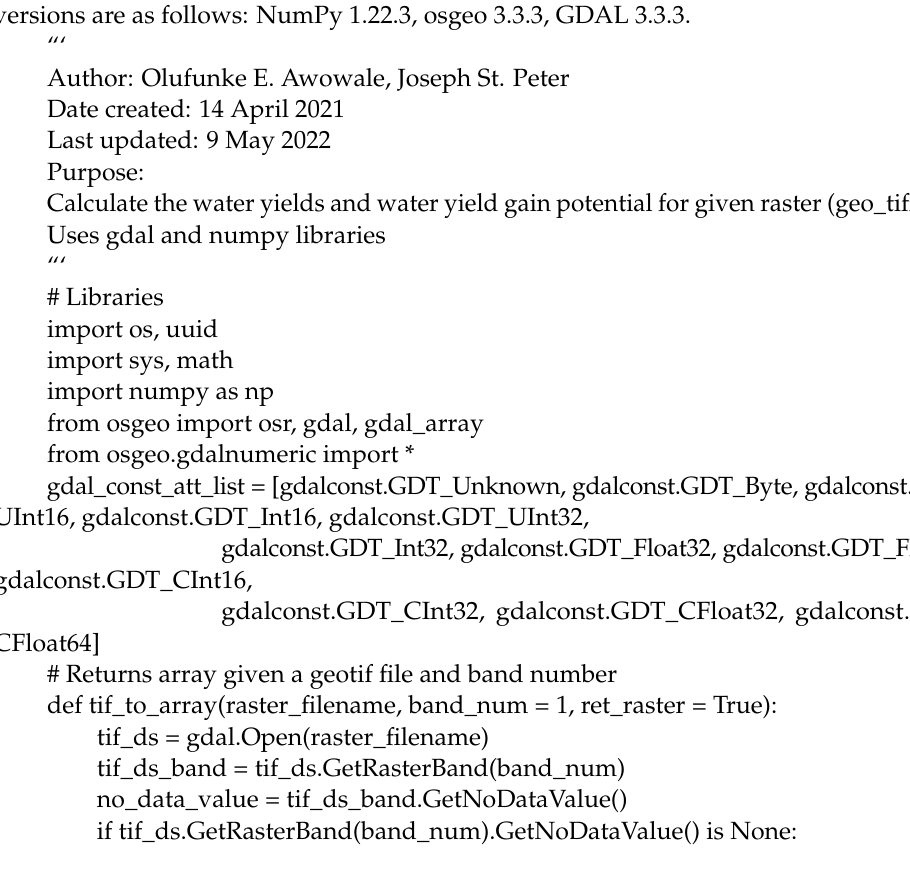
Figure A6. The geoprocessing window when using the Scenario Water Yield Calculation